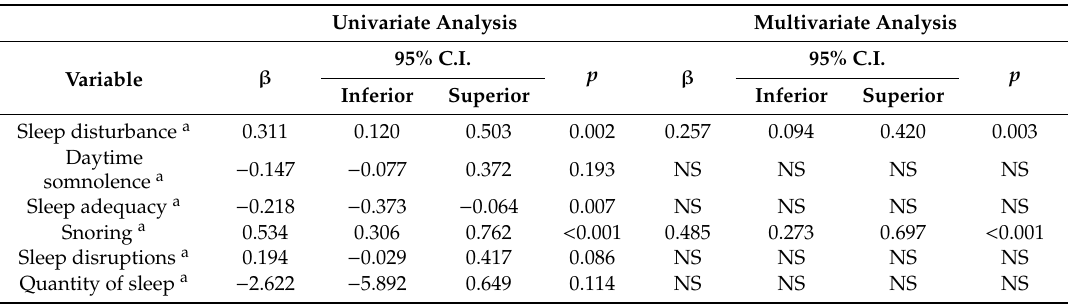
Table 5. Univariate and multivariate linear regression to analyze the factors related to frequency of migraine.